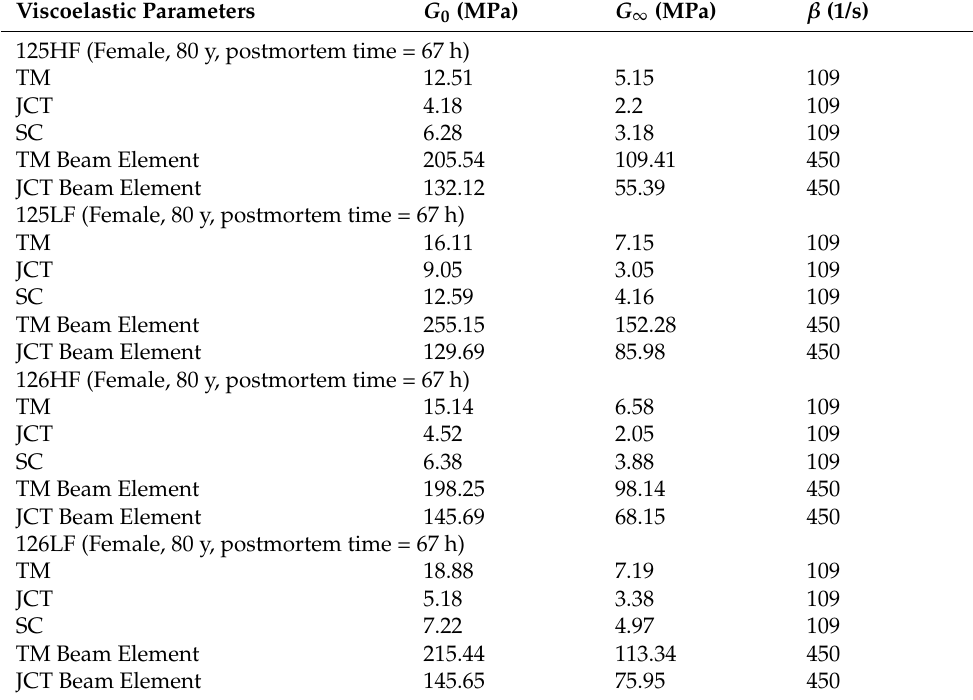
Table 4. Viscoelastic parameters for the healthy TM, JCT, and SC inner wall FE model in glaucoma eyes. The ECM and beam elements were modeled as the viscoelastic